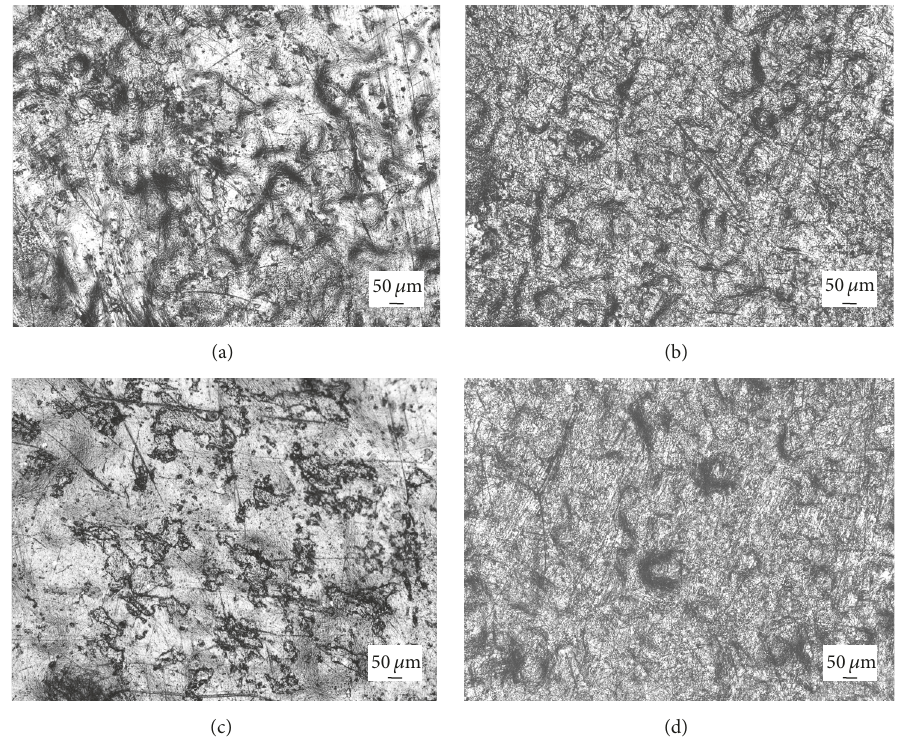
Figure 2: SEM micrograph of the fractured surface of the RPP compounds and unmodified RPP. (a) RPP; (b) RPP/SEBS; (c) RPP/SIS30; (d) RPP/SIS20.